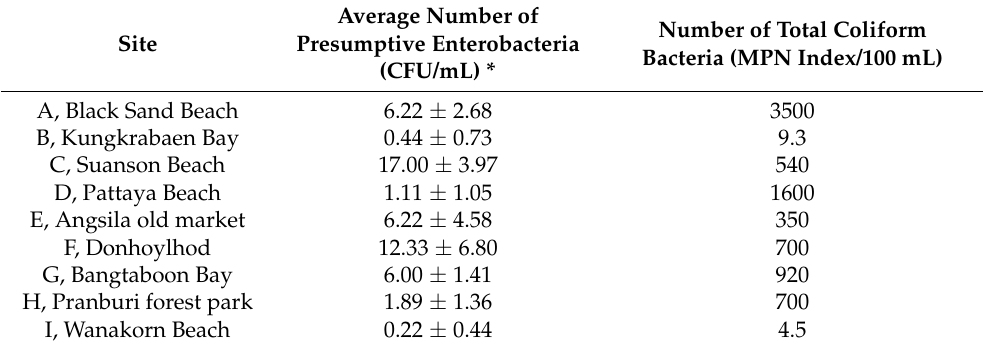
Table 3. Average numbers of presumptive enterobacteria and numbers of total coliform bacteria in sampling